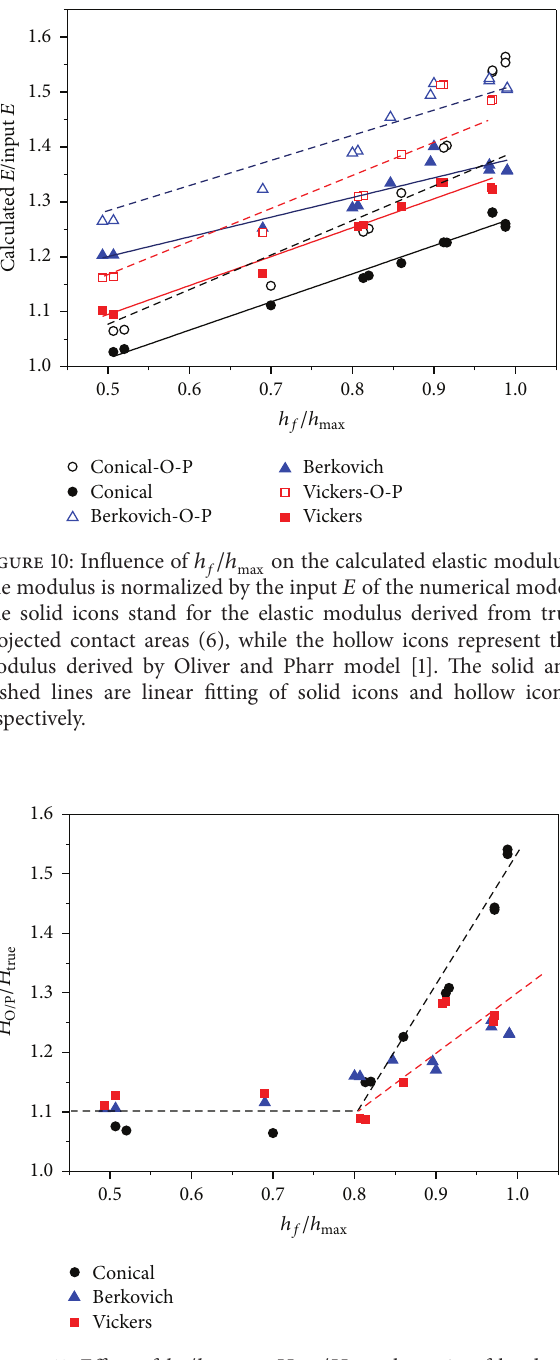
Figure 11: Effect of ℎ 𝑓 /ℎ max on 𝐻 O / P /𝐻 true , the ratio of hardness derived by Oliver and Pharr model to that calculated by using true projected contact area.